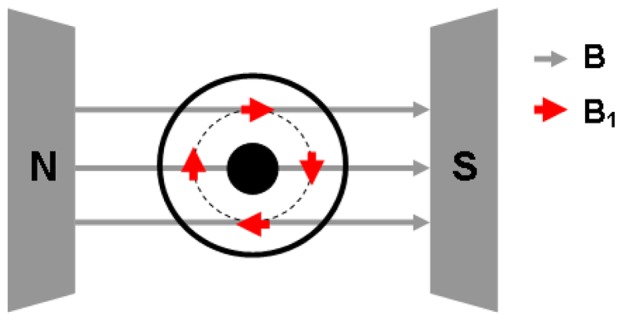
A coaxial structure with its TEM propagation axis perpendicular to the B-axis of an external magnetic field.The microwave magnetic-field component B1 in the sample compartment runs through all possible angles with respect to the external field vector B.